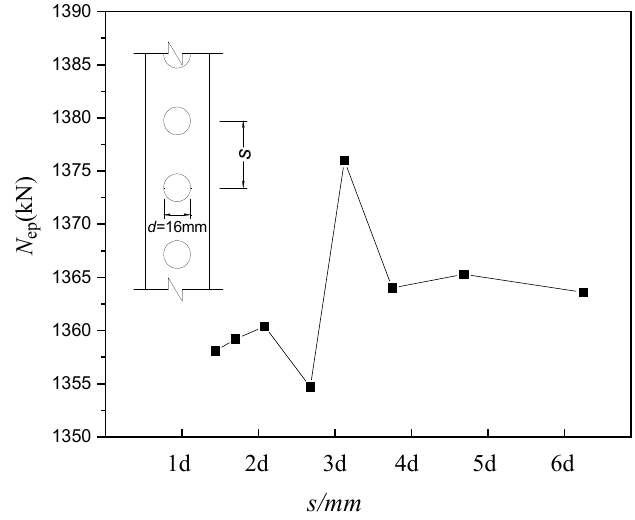
Figure 20. Effect of opening spacing 𝑠 on ultimate strength.